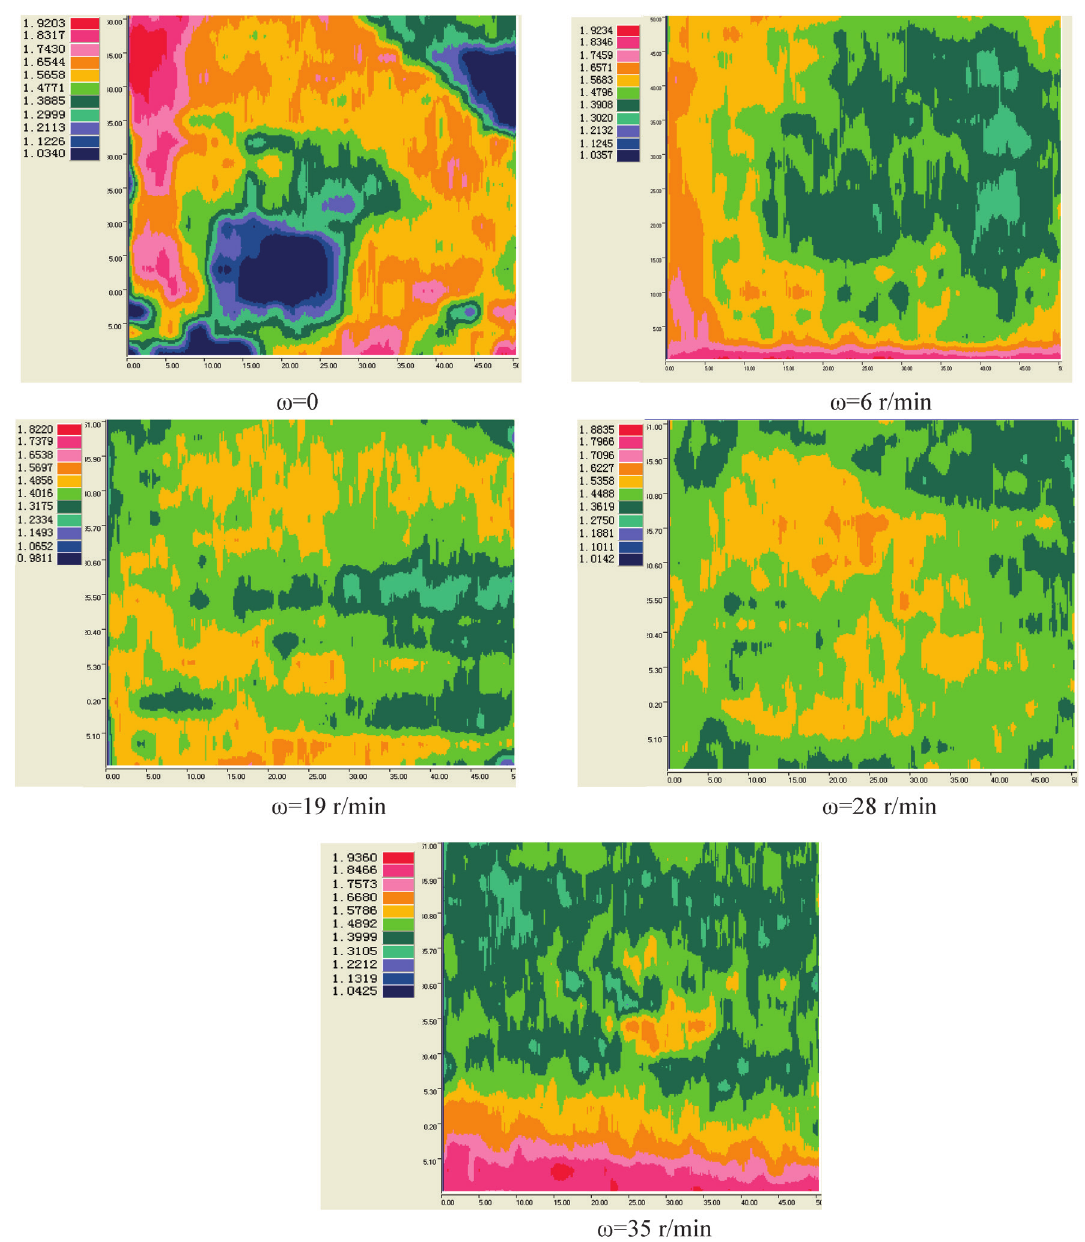
Fig. 5: Effects of mould rotation on chromium